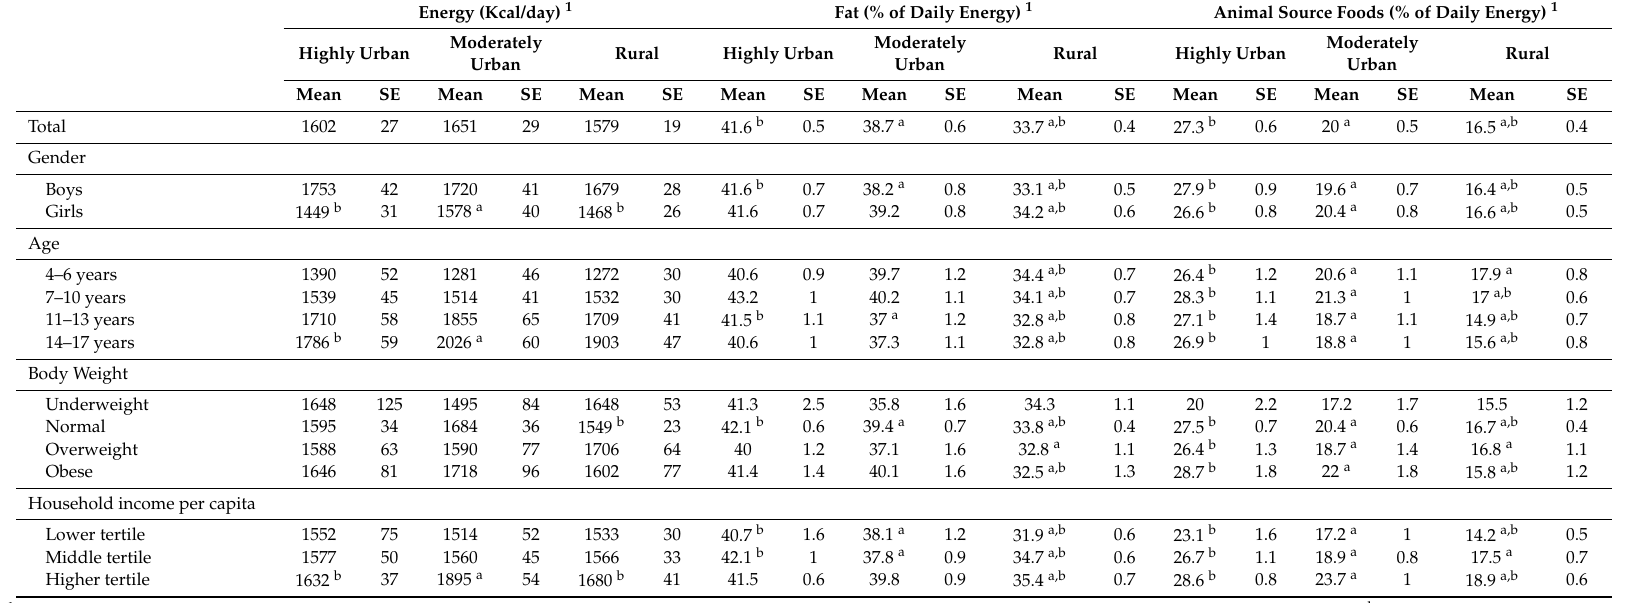
Table 3. Daily energy intake, percent fat and percent of energy from animal source foods, by community types, CHNS2011.